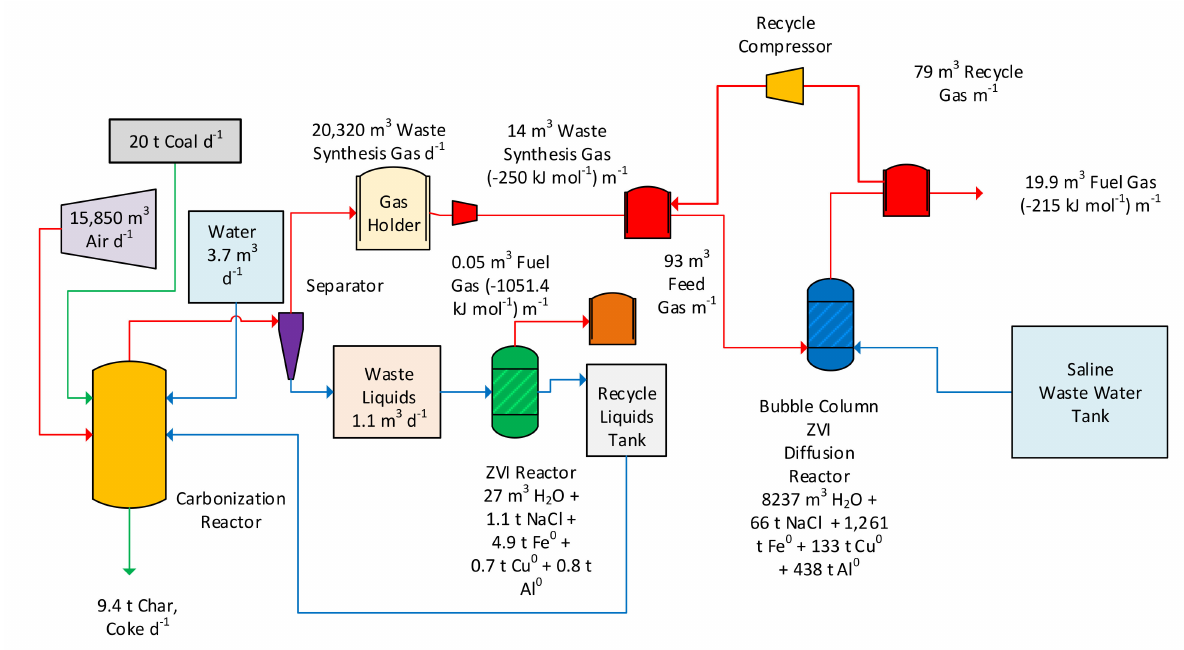
Figure 26. Example process flow diagram for a plant manufacturing 16,000 t a − 1 of desalination